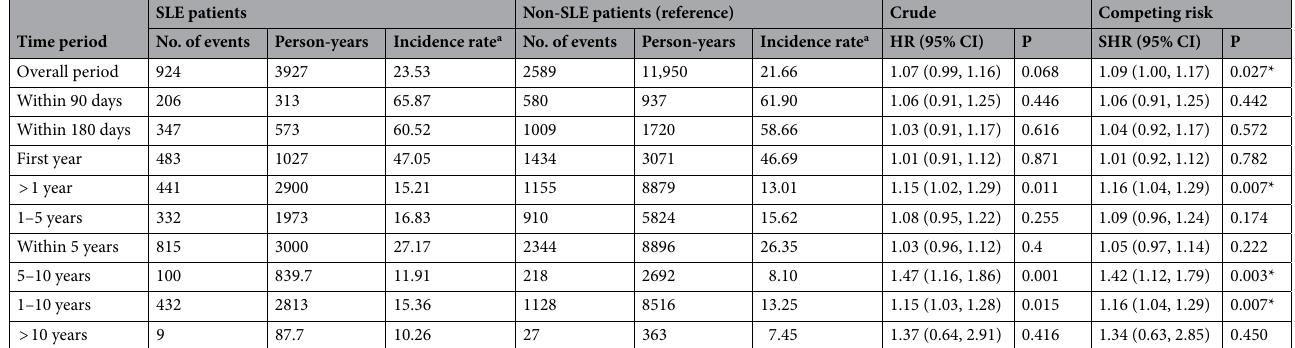
Table 2. Incidence rates and risks of AVF/AVG dysfunction in SLE and non-SLE patients. AVF arteriovenous fistula, AVG arteriovenous graft, SLE systemic lupus erythematosus, HR hazard ratio, SHR subdistribution hazard ratio, CI confidence interval. a Per 100